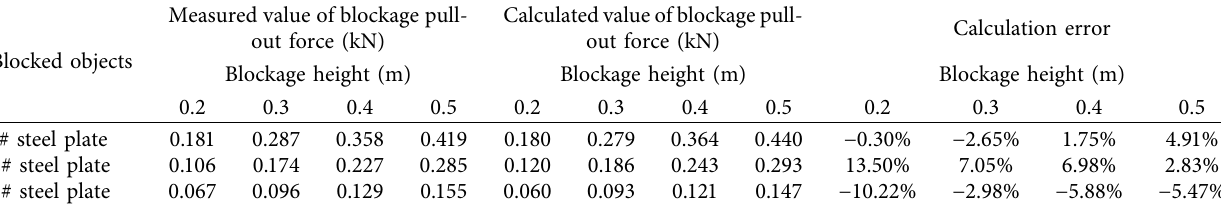
Table 11: Verification analysis of the pull-out force of underwater (mixed) silt.